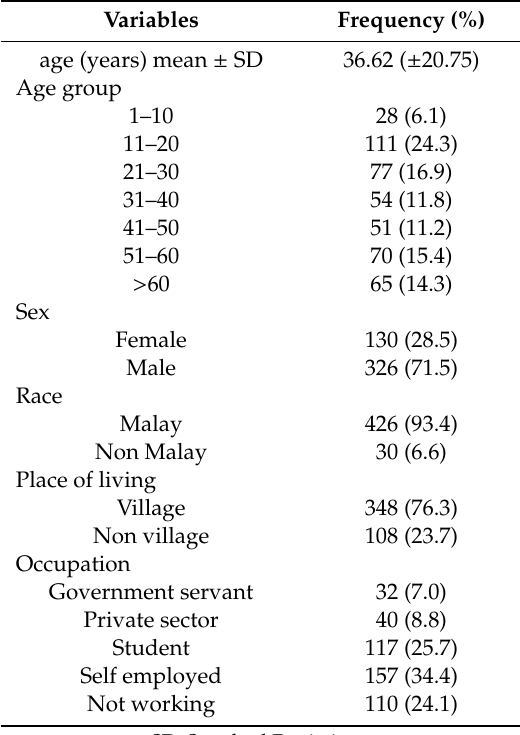
Table 1. Socio-demographic factors for leptospirosis (n = 456).